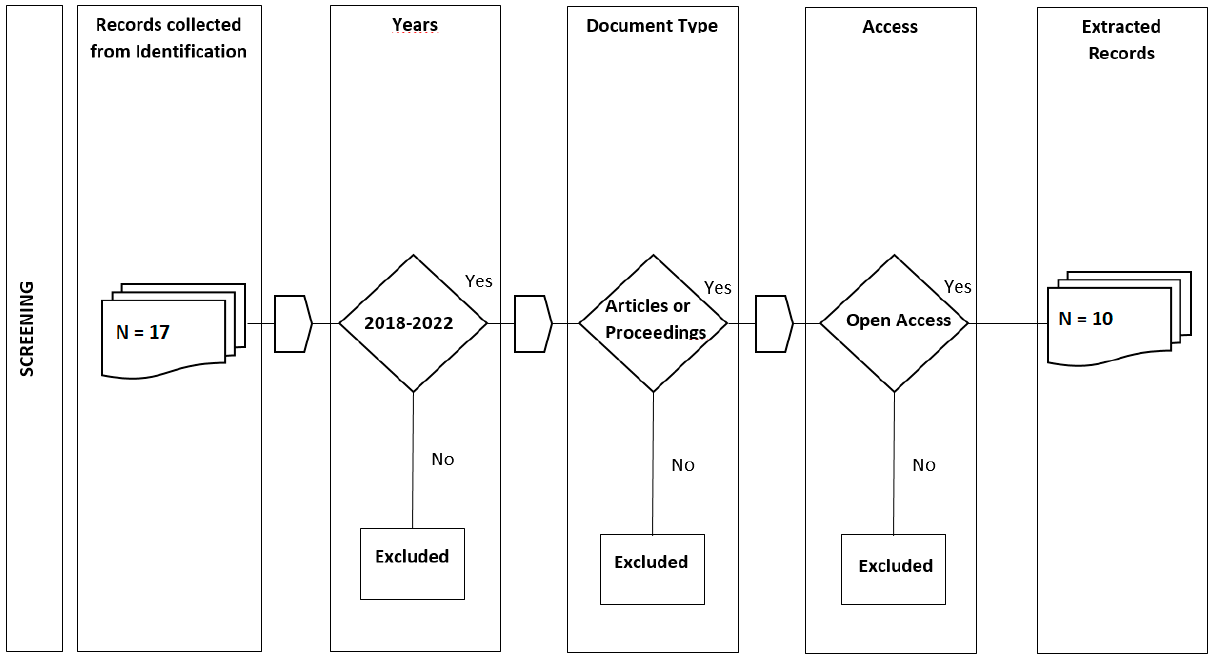
Figure 7. Screening step of the PRISMA framework related to Logistics 4.0 in the SME sector. Source: own study based on the PRISMA methodology.